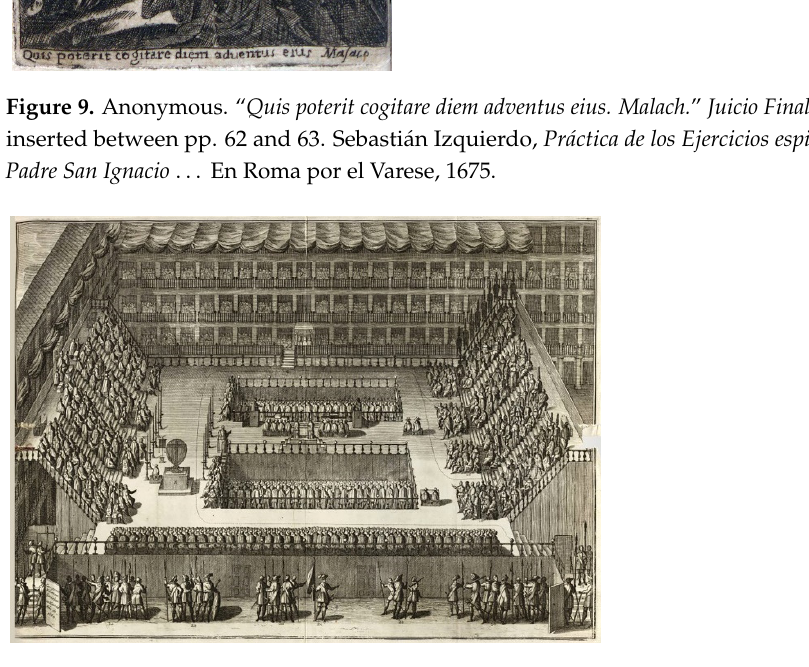
Figure 10. Gregorio Fosman, Auto de Fe . Plaza Mayor de Madrid. 1680. Relación Histórica del Auto General de le Fe… Por Joseph del Olmo… Impresso por Roque Rico de Miranda, Año 1680. The engraving is inserted between pp. 138 and 139.